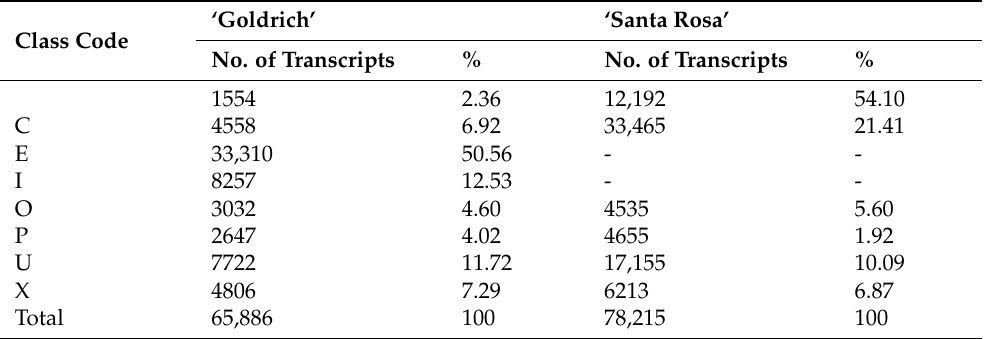
Table 5. Summary of the transcript class assembled in apricot ‘Goldrich’ and Japanese plum ‘Santa rosa’ using Cufflinks cuffcompare v2.2.1. Class codes described by Cuffcompare: =, exactly equal